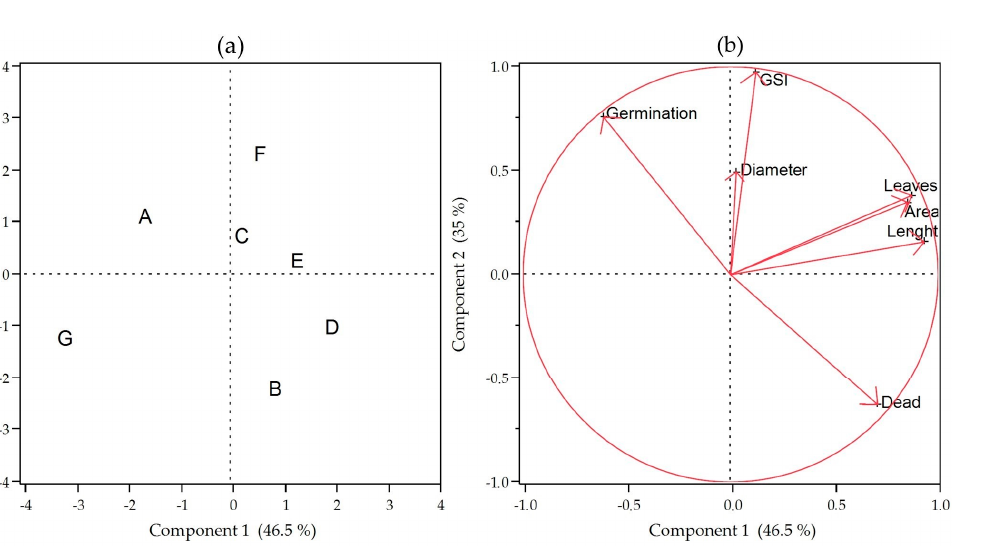
Figure 3. Score graph ( a ) and load graph ( b ) of PCA of seven parameters evaluated in C. brasiliense seedlings at 60 days after sowing, from seeds stored for 40 days, submitted to seven treatments (six concentrations of GA 3 and dry seeds without pre-soaking). Score chart legend ( a ): 0 mg L − 1 of GA3 (A), 50 (C), 100 (B), 500 (F), 1000 (E), 2000 (D), and dry seeds (G). Load graph legend ( b ): stem length, stem diameter, number of leaves, leaf area, germination speed index (GSI), percentage of germination, and percentage of dead seeds. PC1 was responsible for 46.5% of the total variation, being effective in separating